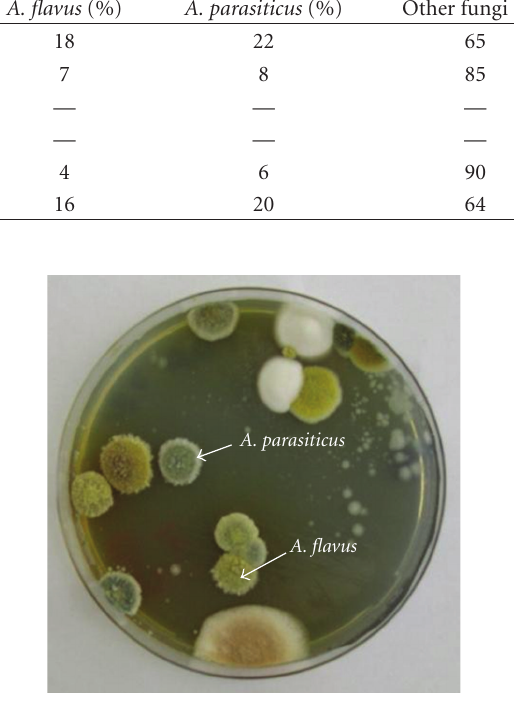
Figure 1: A. flavus and A. parasiticus colonies grown on CZ plate isolated from nuts sample.